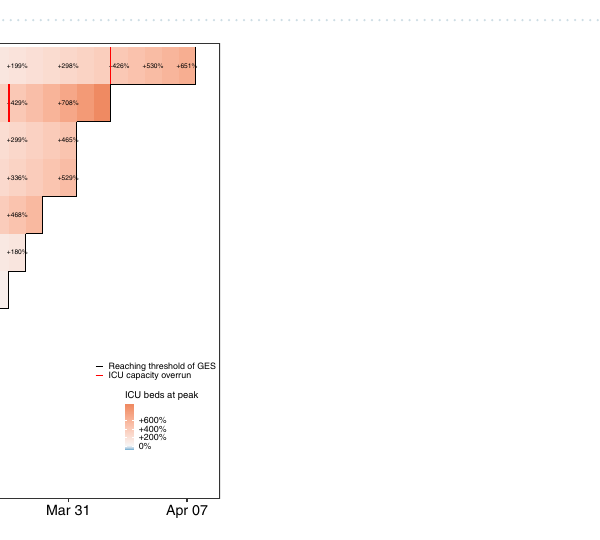
Figure 1. Impact of the change of the lockdown date on the national number of ( a ) hospital admissions, ( b ) ICU admissions, ( c ) deaths, ( d ) life years, ( e ) quality-adjusted life years lost per 100,000 inhabitants compared to the observed lockdown date and on ( f ) the ICU occupancy. ICU intensive care unit, QALY quality-adjusted life years.